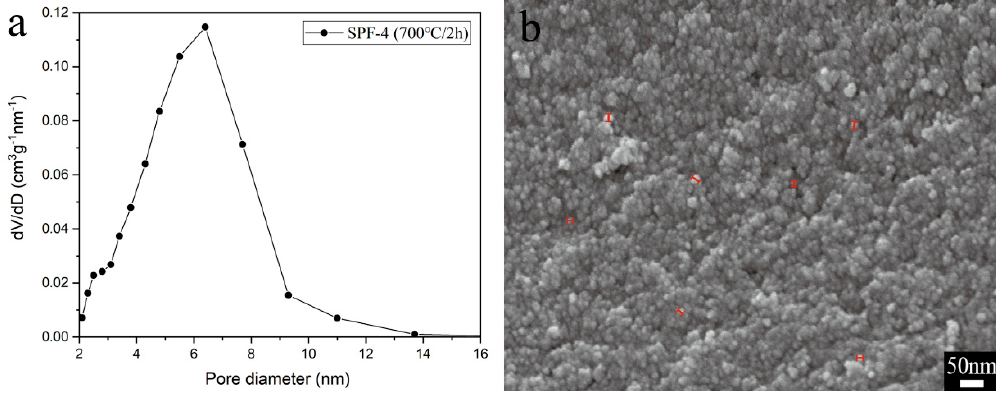
Figure 11. BJH (Barrett-Joyner-Halenda) pore size distribution plots ( a ) and SEM image ( b ) of the cured SPF-4 resins oxidized for 2 h at 700 °C.